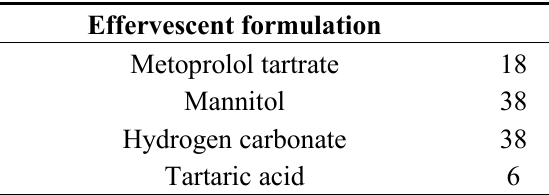
Table 1. Composition of the powder mixture for the manufacturing of the effervescent formulation by a wet-extrusion process (%).